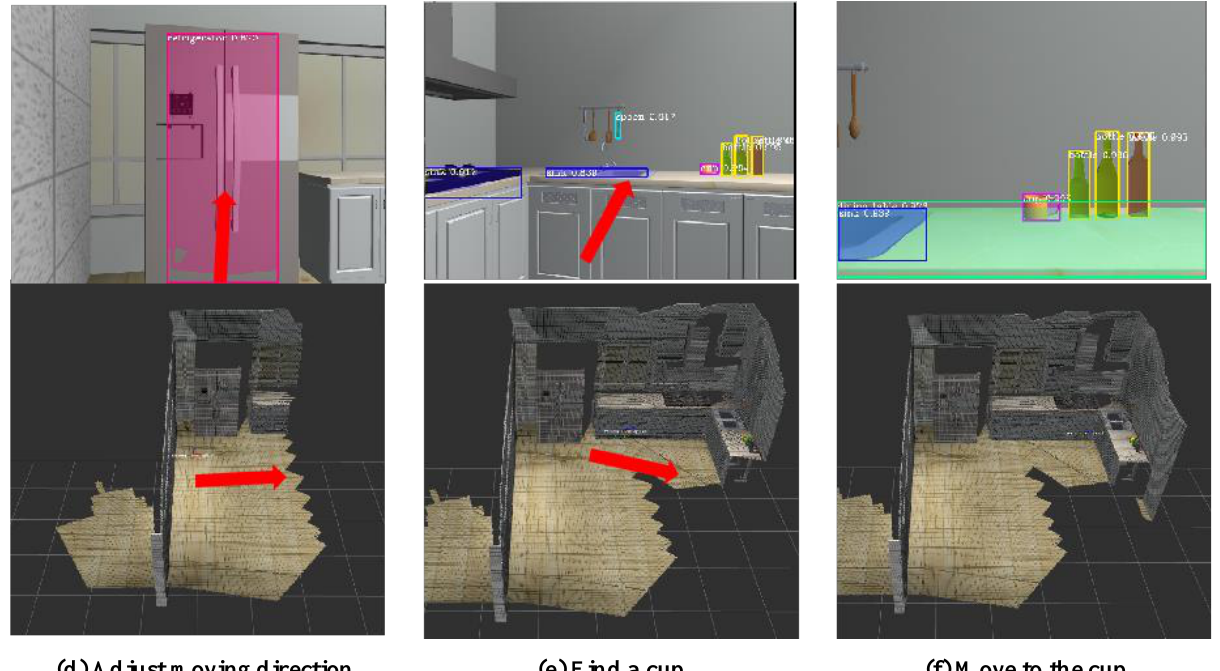
Figure 12. The process of the robot navigating to the cup.